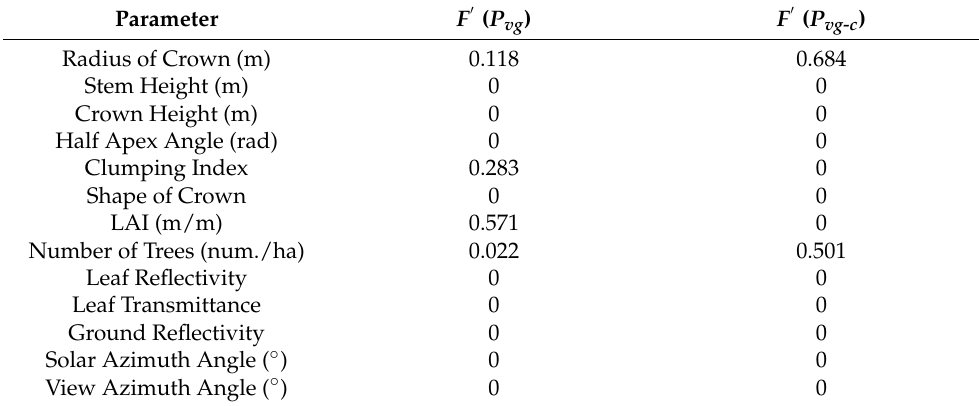
Table 2. Sensitivity analysis of the parameters in the GOST model.